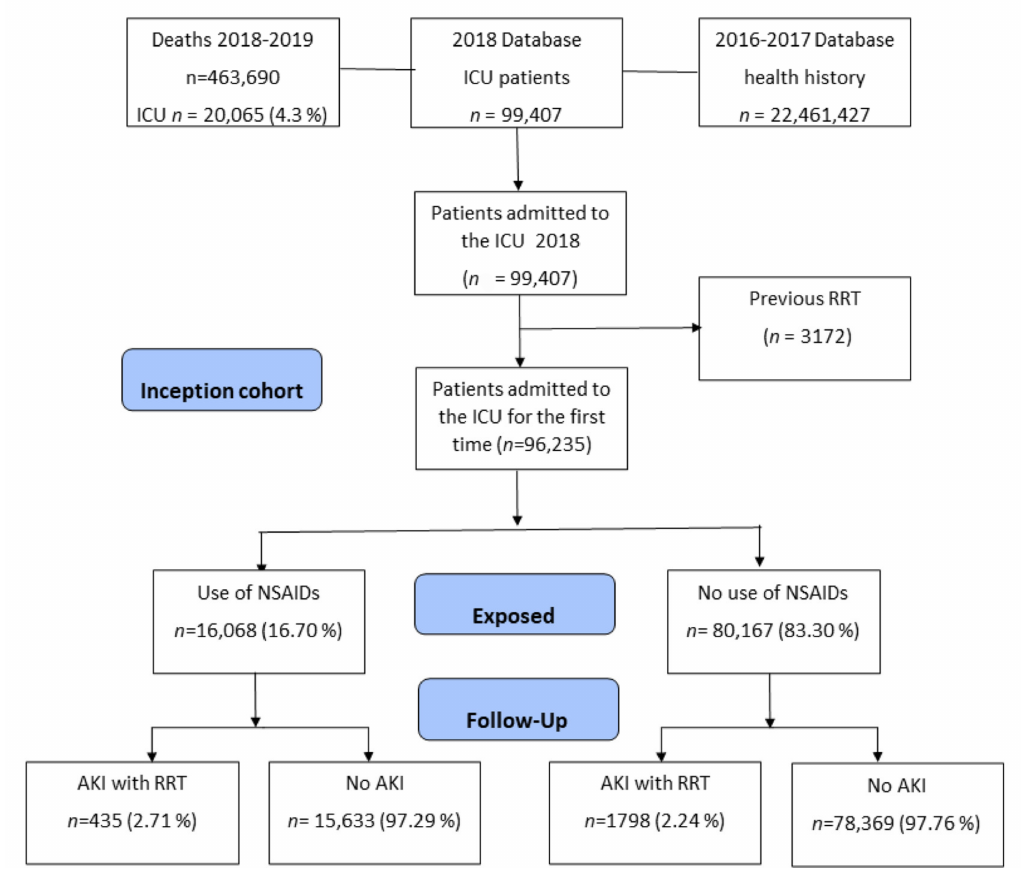
Figure 1. Flowchart of subjects included based on administrative health